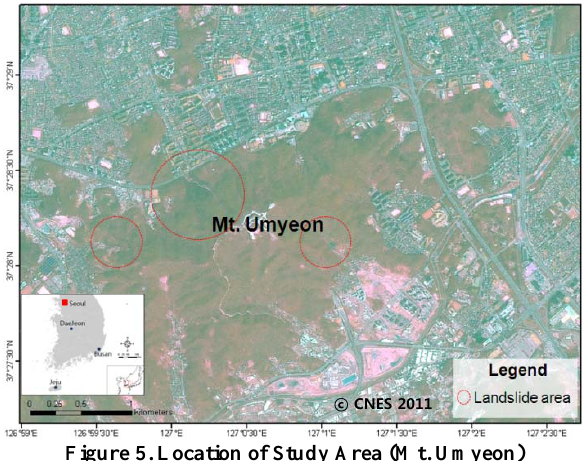
Figure 5. Location of Study Area (Mt. Umyeon)